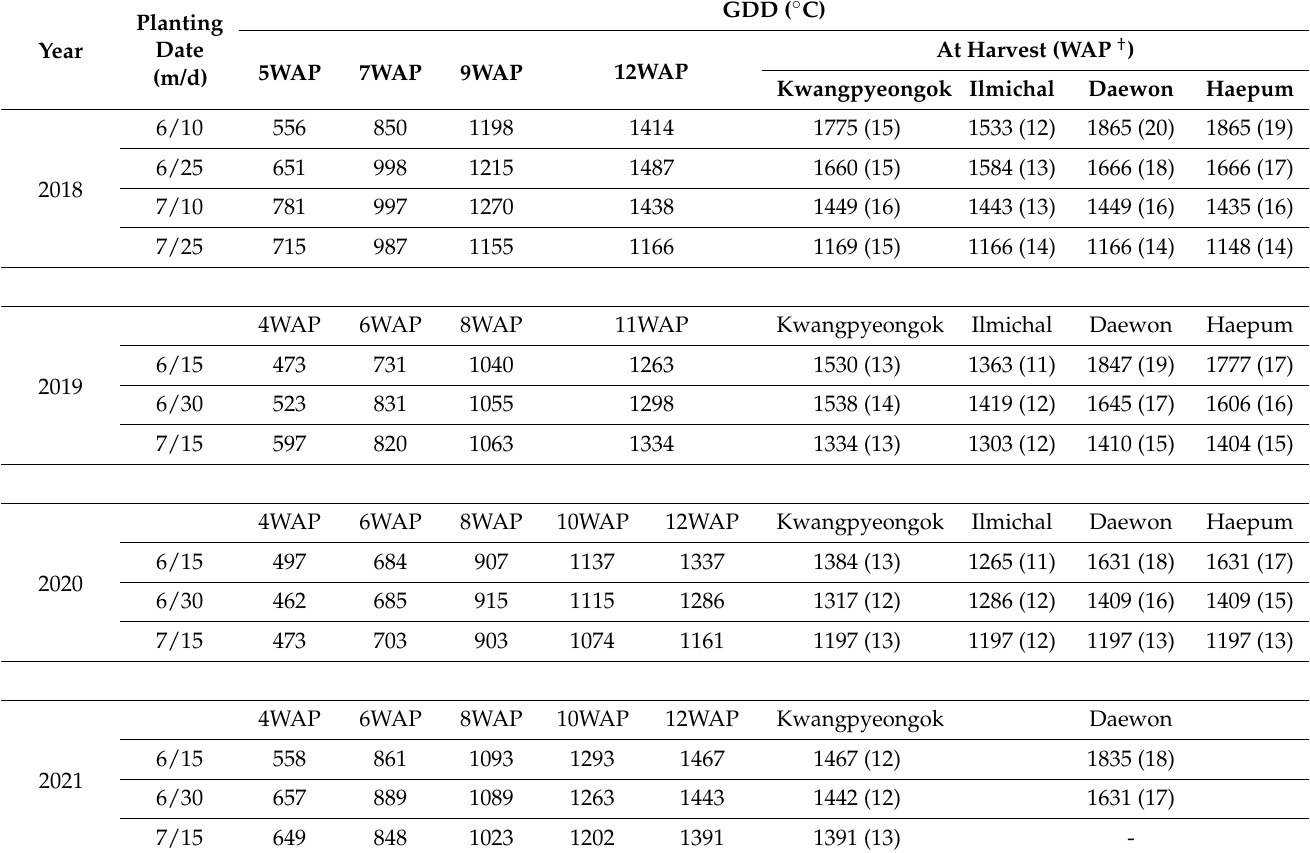
Table 1. Growing degree-days (GDD) during summer growing season for each planting